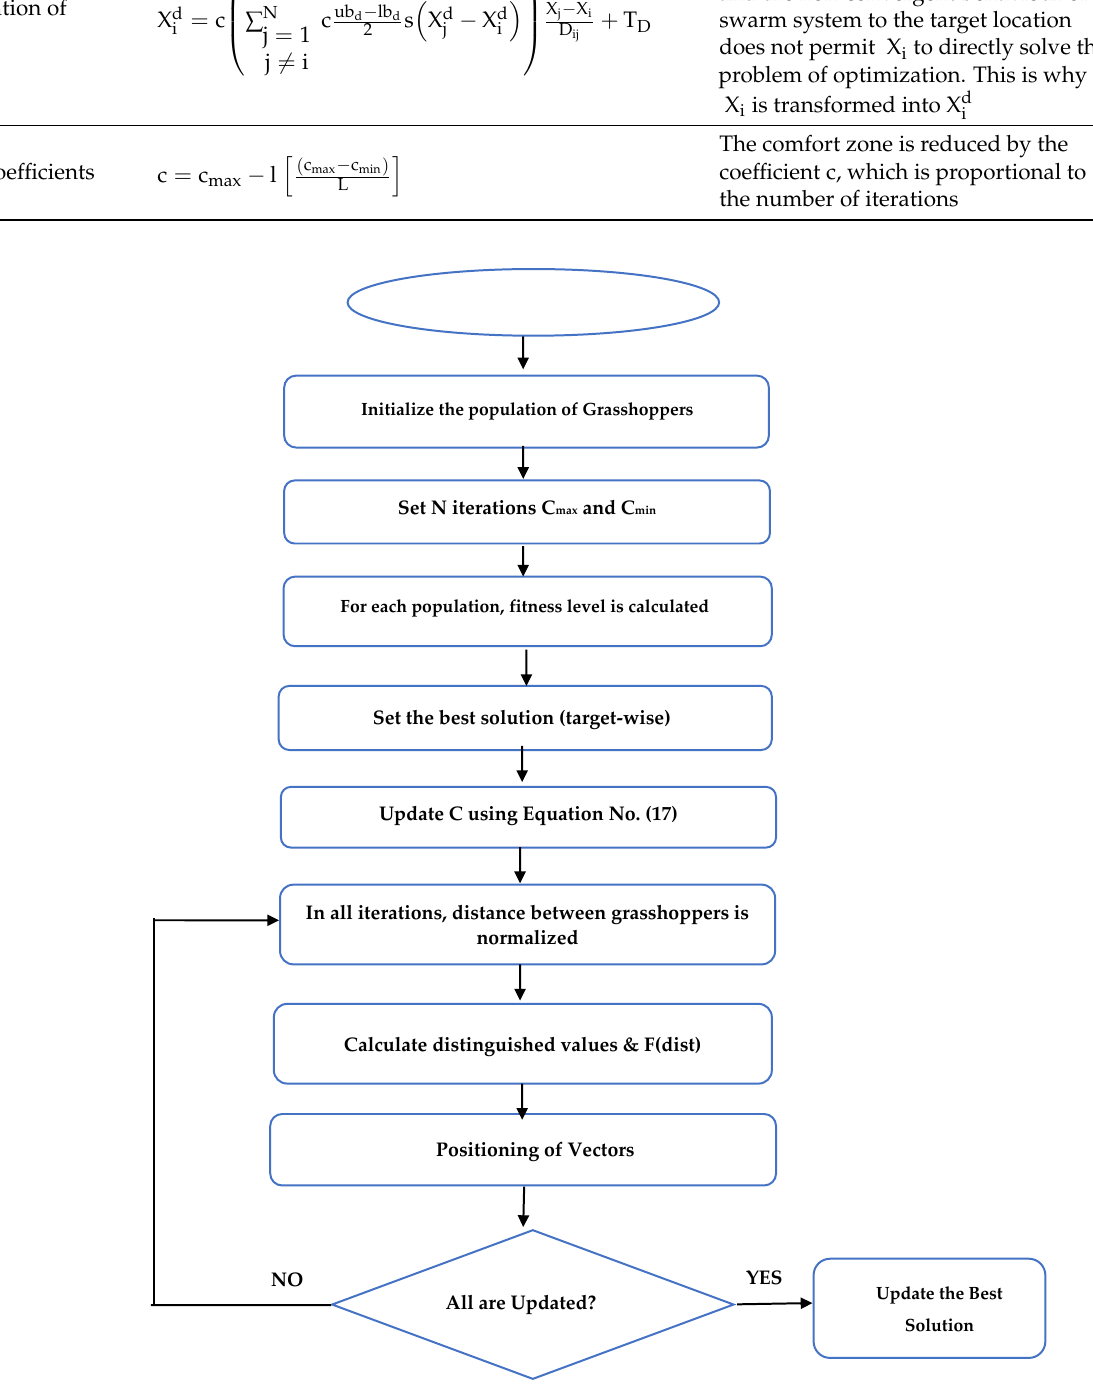
Figure 3. The flowchart of the grasshopper optimization algorithm.